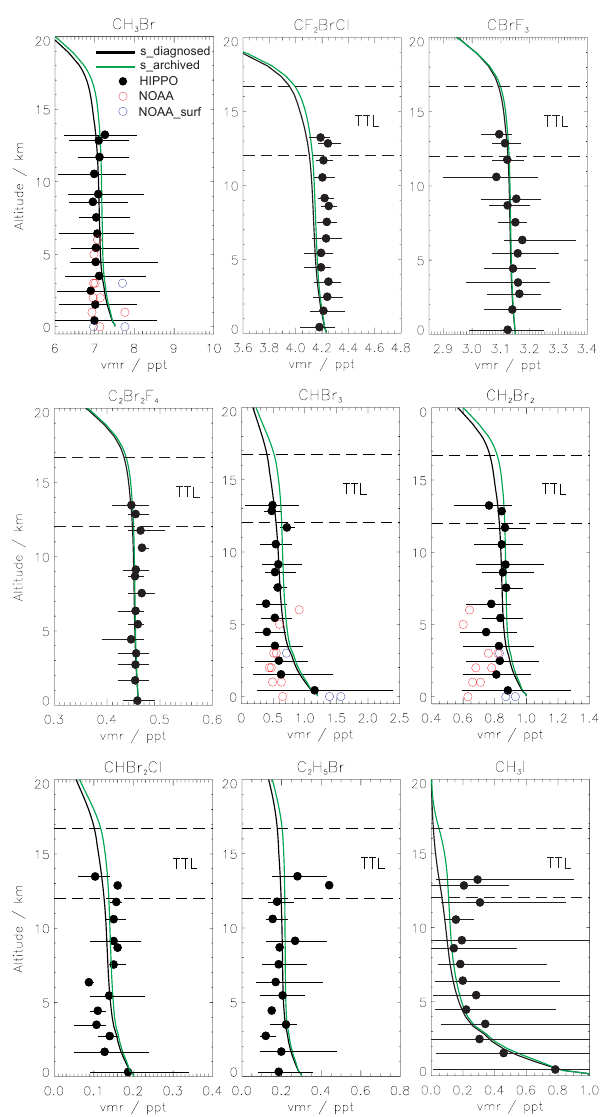
Fig. 1. Mean observed and modelled tropical ( ± 20 ◦ ) mixing ra- tio (ppt) of (a) CH 3 Br, (b) CF 2 BrCl (H1211), (c) CBrF 3 (H1301), (d) C 2 Br 2 F 4 (H2402), (e) CHBr 3 , (f) CH 2 Br 2 , (g) CHBr 2 Cl, (h) C 2 H 5 Br and (i) CH 3 I. Observations (filled circles) taken from the NSF HIPPO-1 campaign (January 2009). Horizon- tal bars denote min-max variability of observations at given level. Open circles denote observations during January 2009 from three NOAA/ESRL surface sites (blue points from SMO, 14.3 ◦ S, 170.6 ◦ W, 77ma.s.l.; MLO, 19.5 ◦ N, 155.6 ◦ W, 3397ma.s.l.; KUM, 19.5 ◦ N, 154.8 ◦ W, 3ma.s.l.) or from vertical profiles (red points sampled over Raratonga, 21 ◦ S, 159.8 ◦